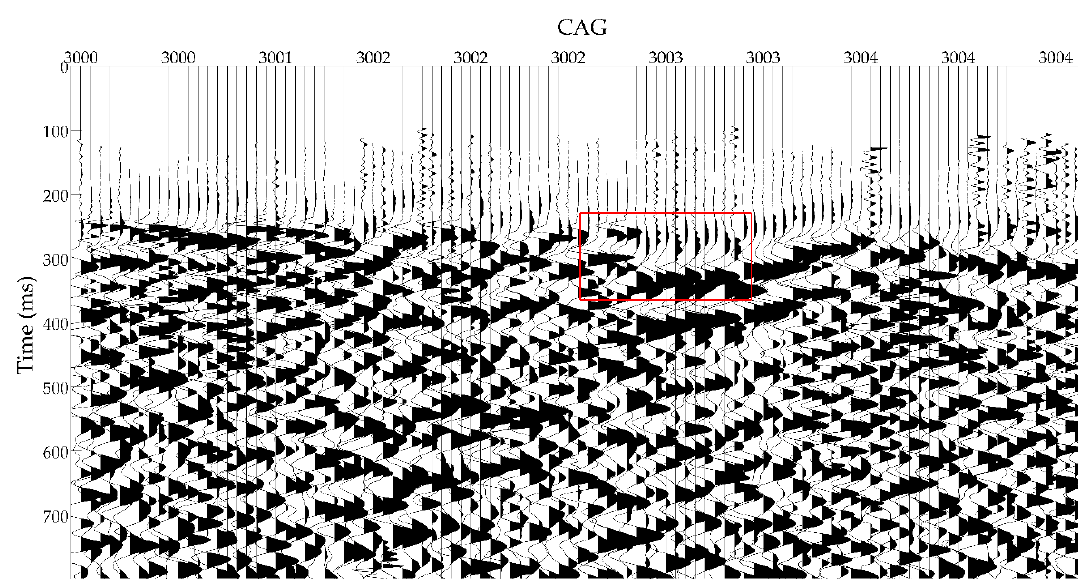
Figure 5. Common receiving-point gather (CRG) (No. 825) after LMO.